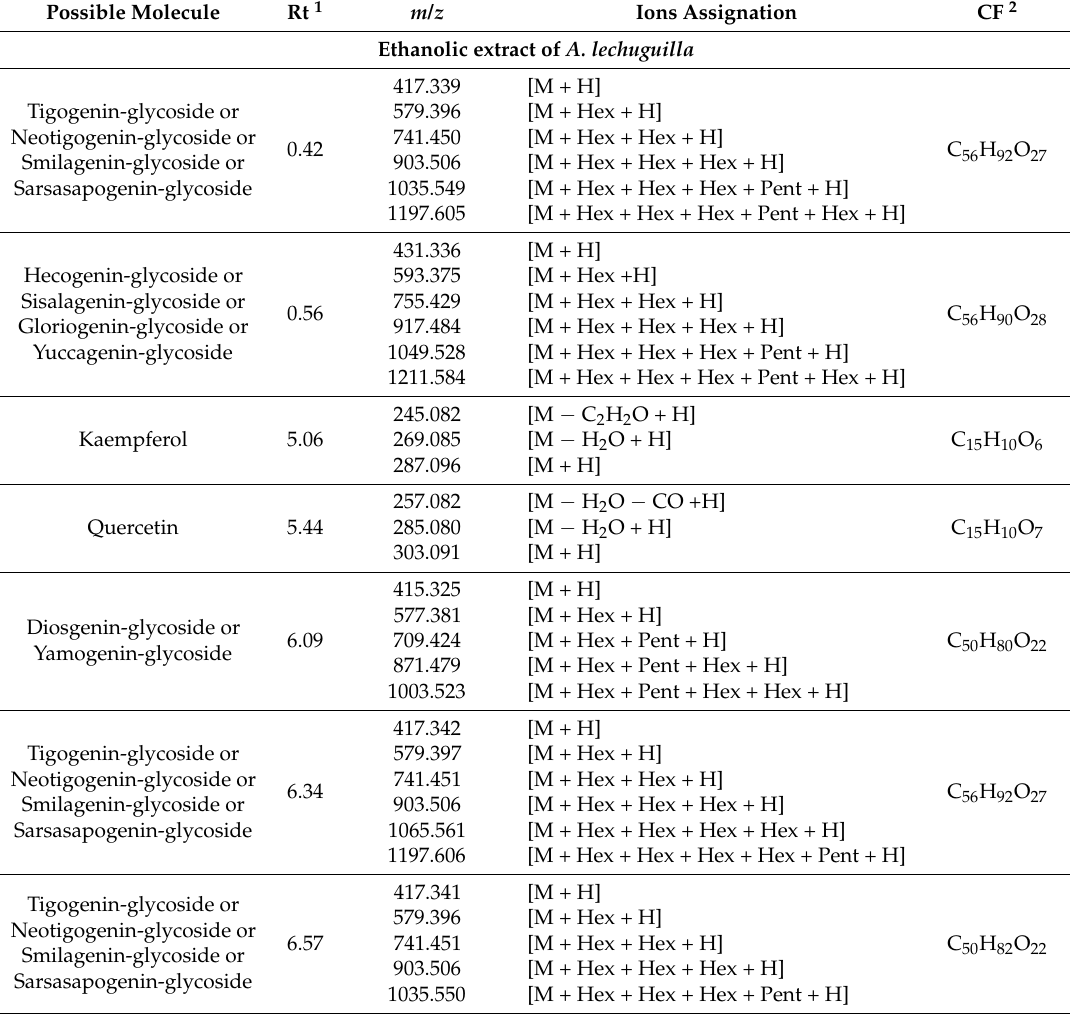
Table 2. Ion assignation and formula condensed of metabolities in extracts from A. lechuguilla . Possible Molecule Rt 1 m / z Ions Assignation CF 2 Ethanolic extract of A.